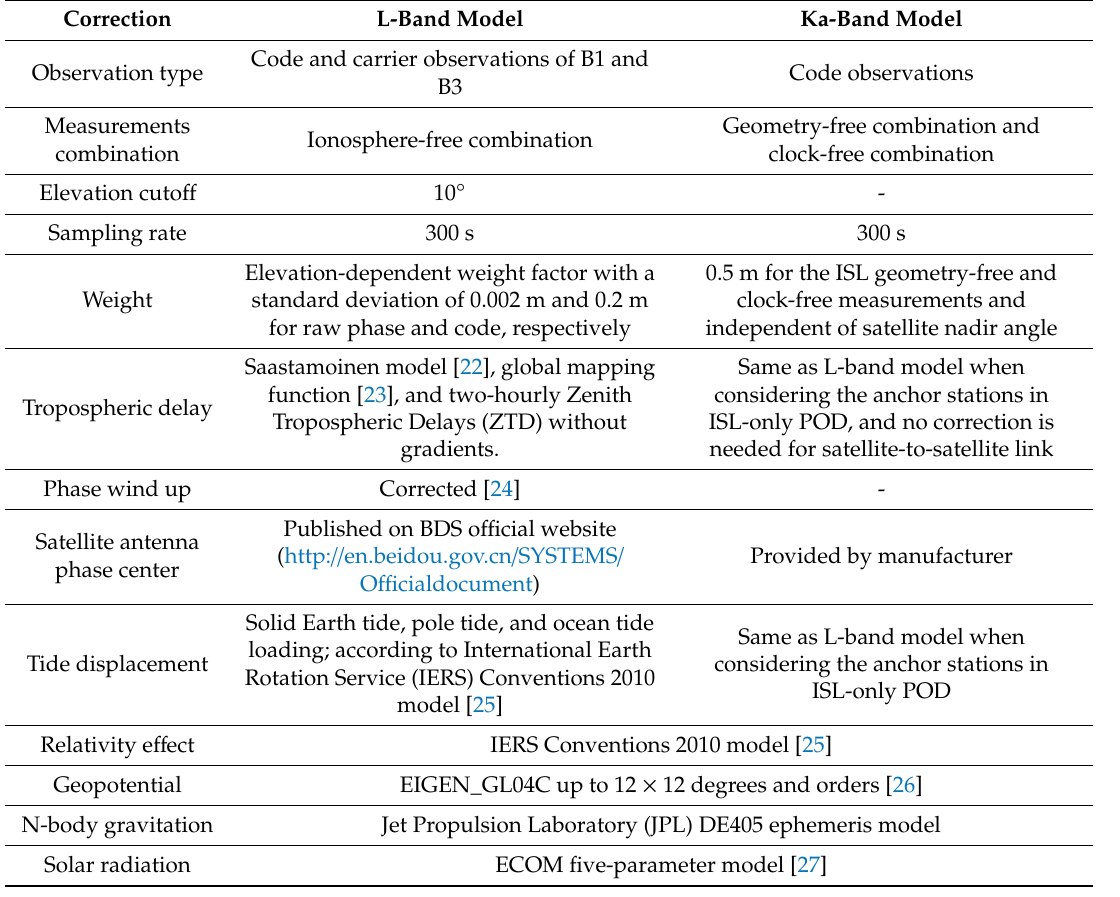
Table 1. Processing strategy for the